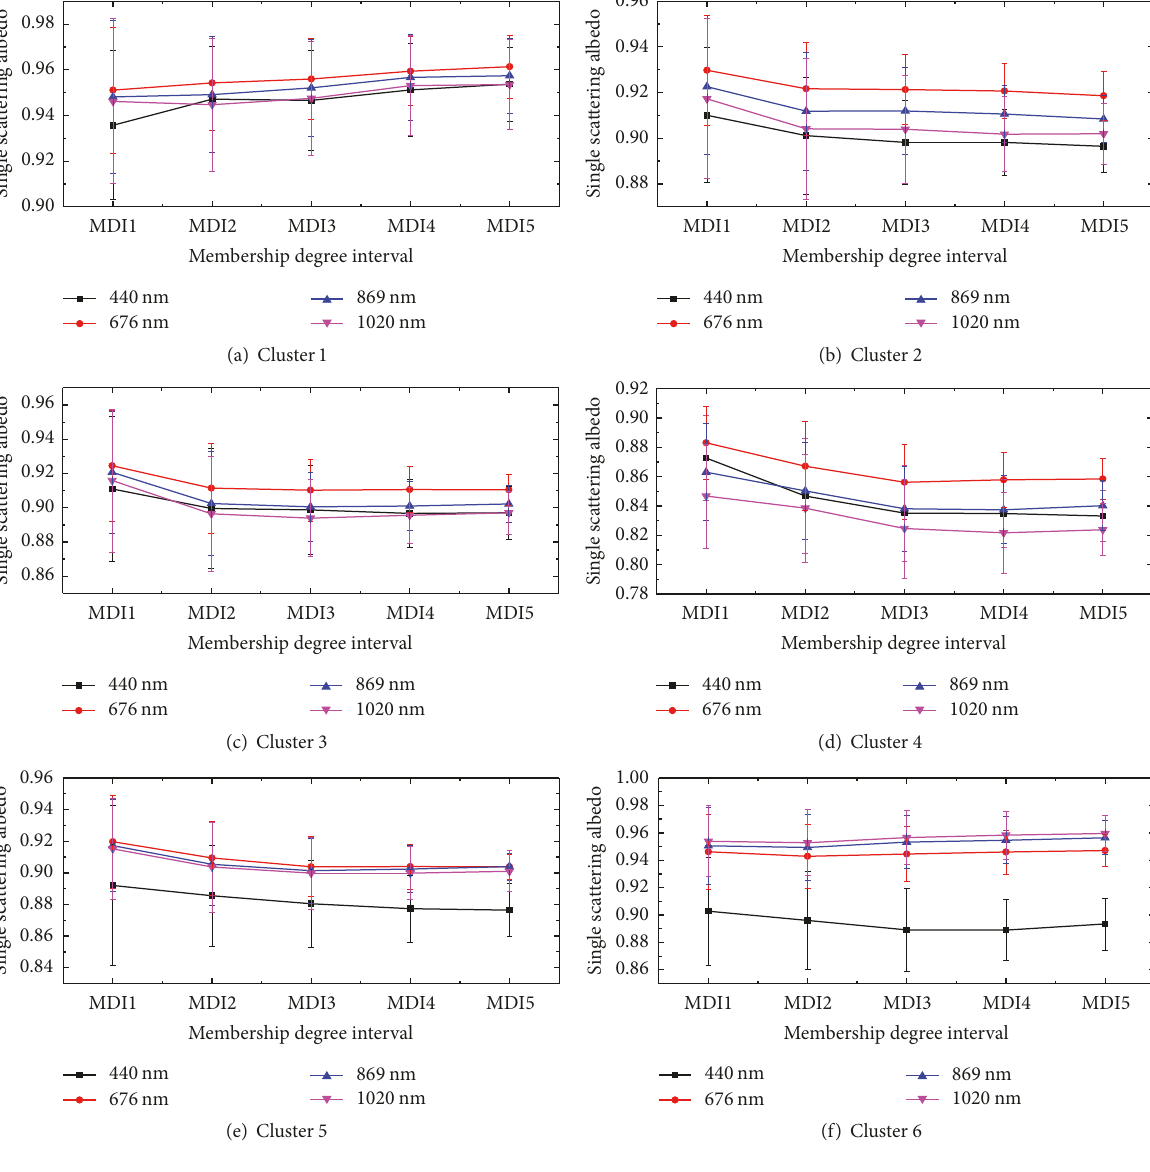
Figure 12: Same as Figure 10 but for